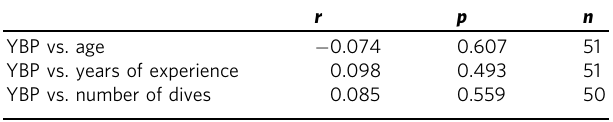
Table 1 Mean (standard deviation) Years Before Present baselines among various respondent types.